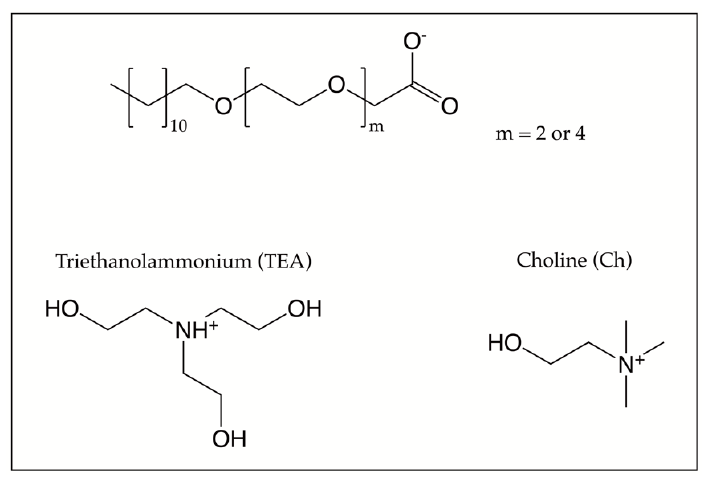
Figure 3. The anions and cations giving SAILs, as discussed in Section 3.